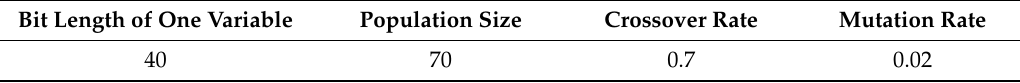
Table 2. The optimal and constant values of parameters used in analysis.